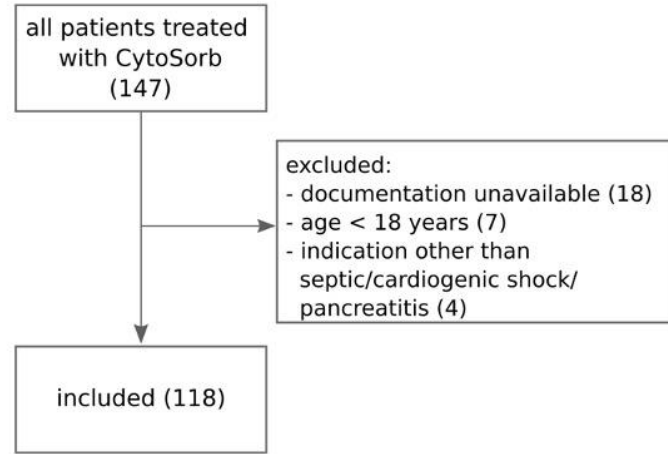
Figure 1. Flowchart of patient selection process. Table 1. Patients’ characteristics at initiation of treatment and outcome. Data are presented as mean ± standard deviation, median [interquartile range] and number (percent) as appropriate.